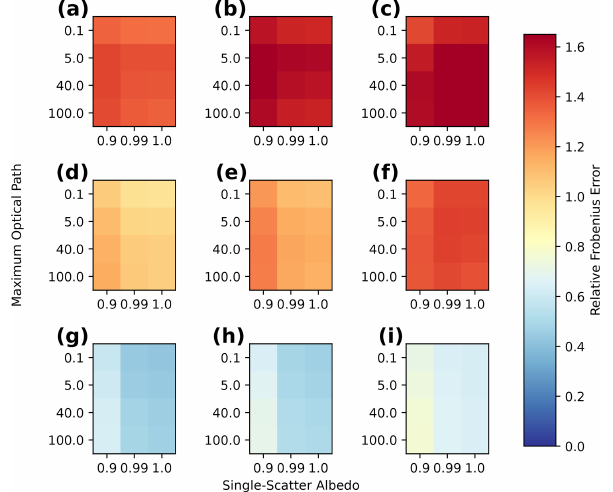
Figure 15. Similar to Fig. 10 but for derivatives of radiances with respect to the extinction within the auxiliary domains that param- eterize the open horizontal BCs. Note the difference in color scale from Fig. 10. Panels (a) , (b) , and (c) have isotropic phase functions. Panels (d) , (e) , and (f) have Mie phase functions, and panels (g) , (h) , and (i) have Mie phase functions with a reduced angular res- olution (see text for details). Panels (a) , (d) , and (g) have a black surface. Panels (b) , (e) , and (h) have Lambertian surface albedos of 0.2, while panels (c) , (f) , and (i) have Lambertian surface albedos of 0.7.